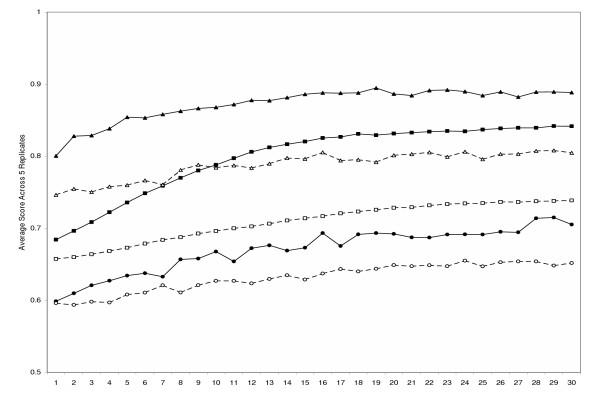
Change in the mean (squares), maximum (triangles) and minimum (circles) generalization scores for the 600 OGA Chromosomes in each of 30 training rounds for set 1.4. Plotted values represent the mean of each value across all 5 replicates of either the experimental (filled shapes, solid line) or negative control runs (empty shapes, dashed line).